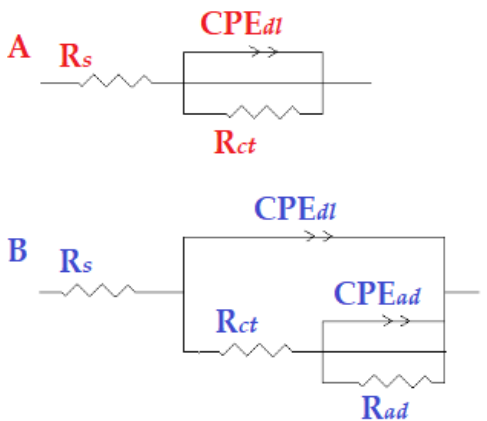
Figure 9. The model of equivalent circuit that was used to fit the experimental data ( A ) without and ( B ) with the addition of the tested inhibitor.